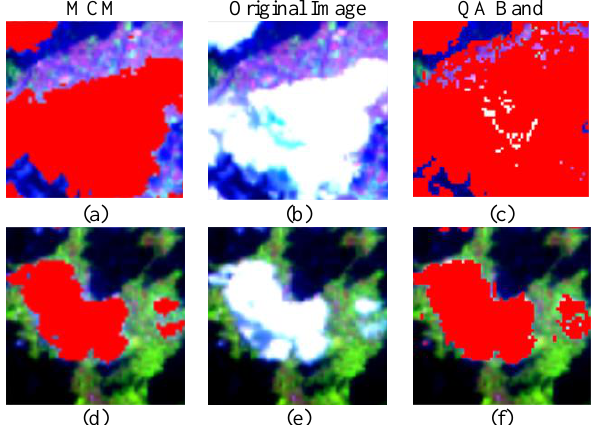
Figure 12. The detail result of cloud masking using QA band. Red colour indicates cloud region.